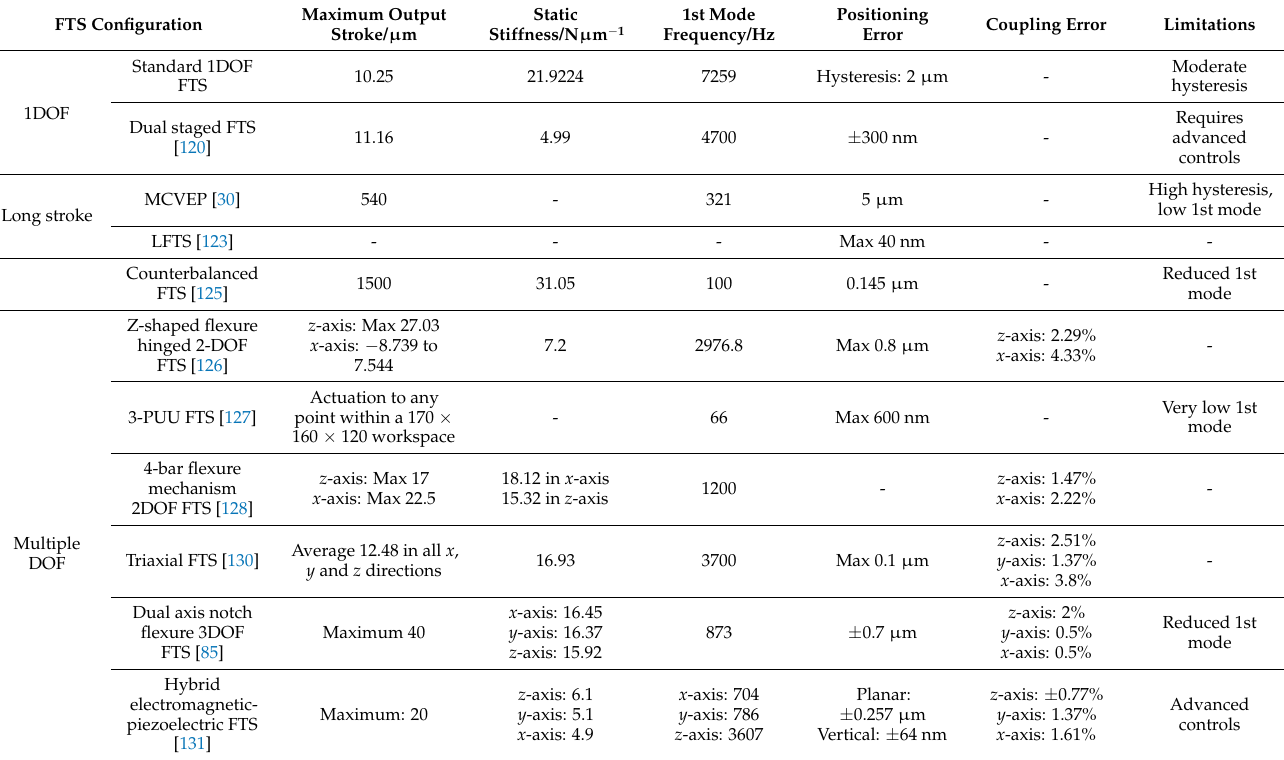
Table 2. Selected CM FTS performance based on output stroke, static stiffness, first mode frequency, tracking and coupling error. ‘-’ indicates absence of